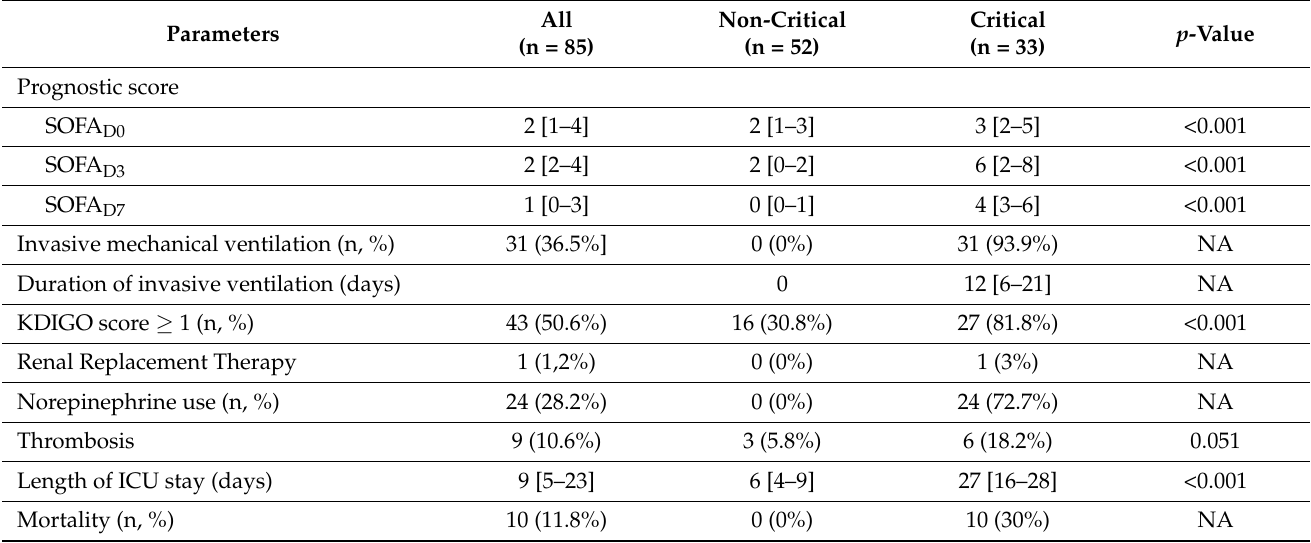
Table 2. Clinical outcomes during the ICU stay of patients admitted with COVID-19 pneumonitis.